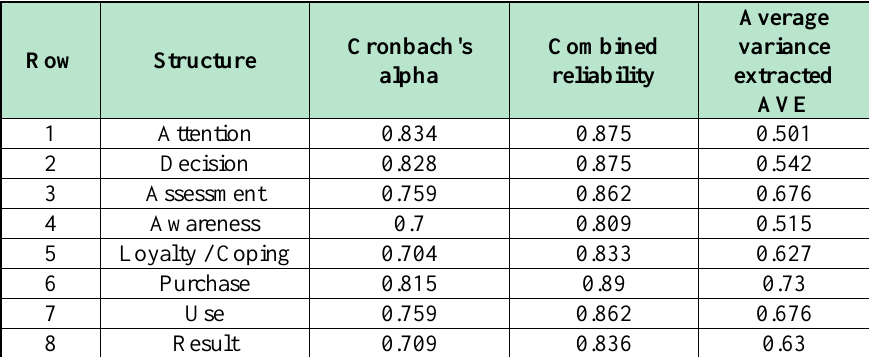
Table 4- Reliability of model structures